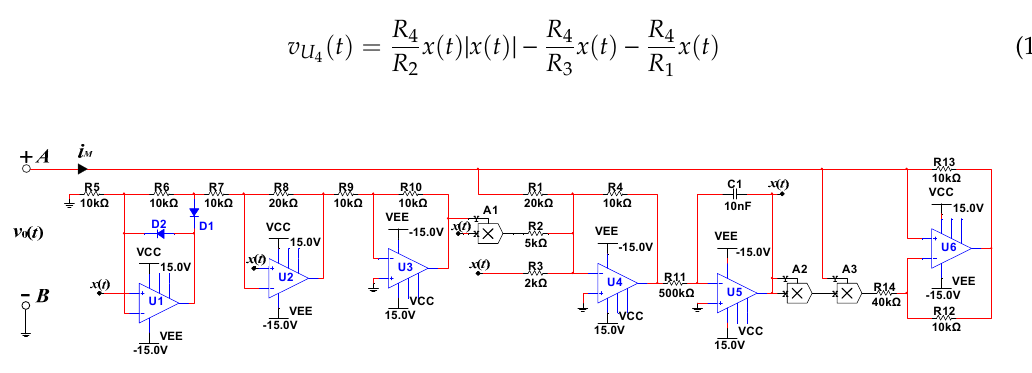
Figure 2. Emulator of the active memristor (AM).